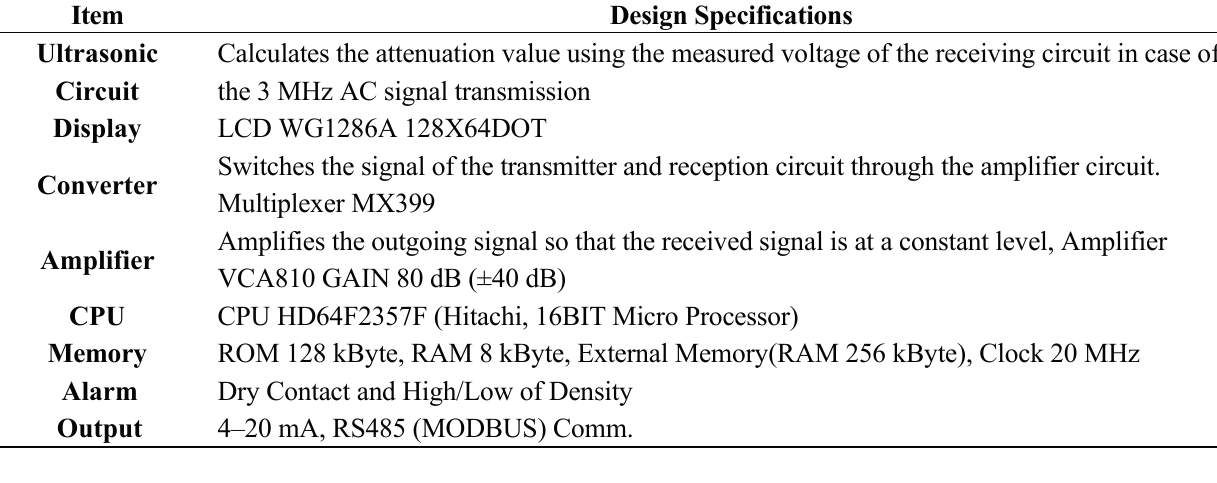
Table 1. Converter design specifications.